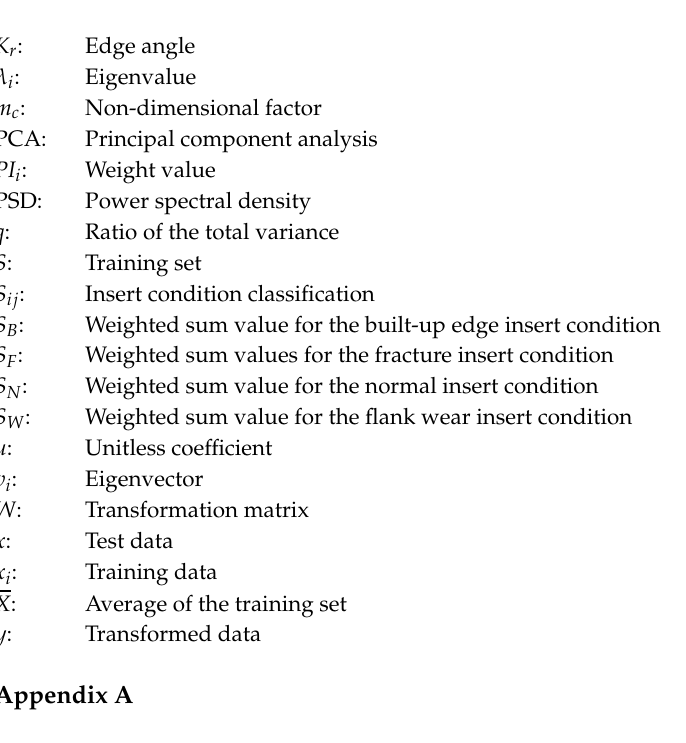
Table A1. List of devices in the experimental setup.